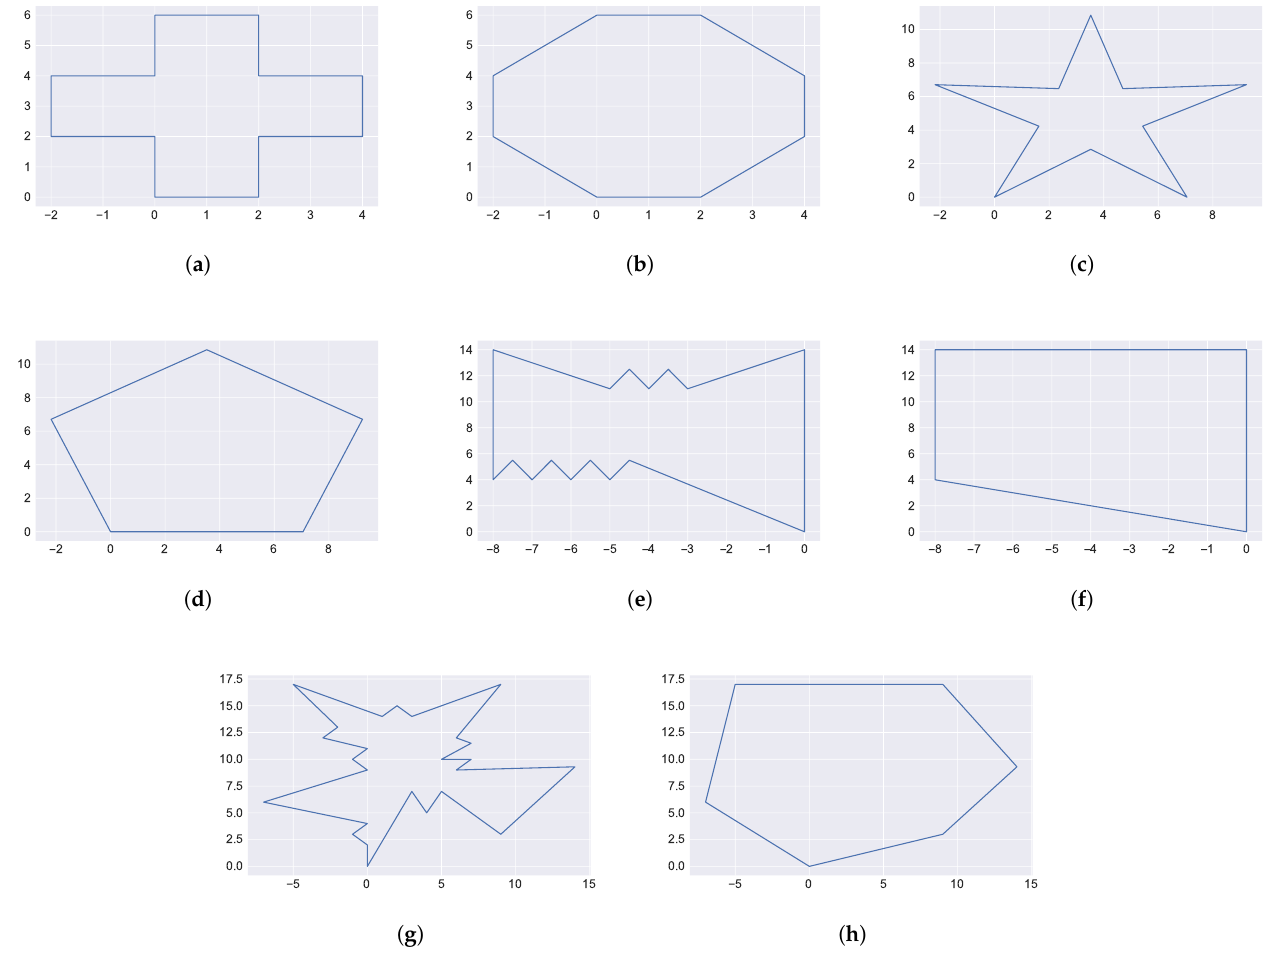
Figure 3. Sample inputs and outputs of VRAOA. ( a ) Input sample 1. ( b ) Output sample 1. ( c )